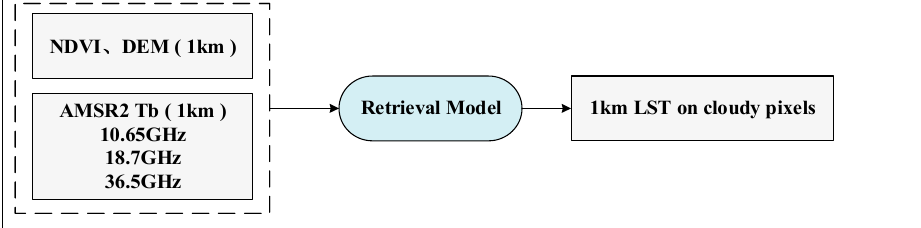
Figure 4. Schematic diagram of the producer for estimating 1 km LST on cloudy pixels.